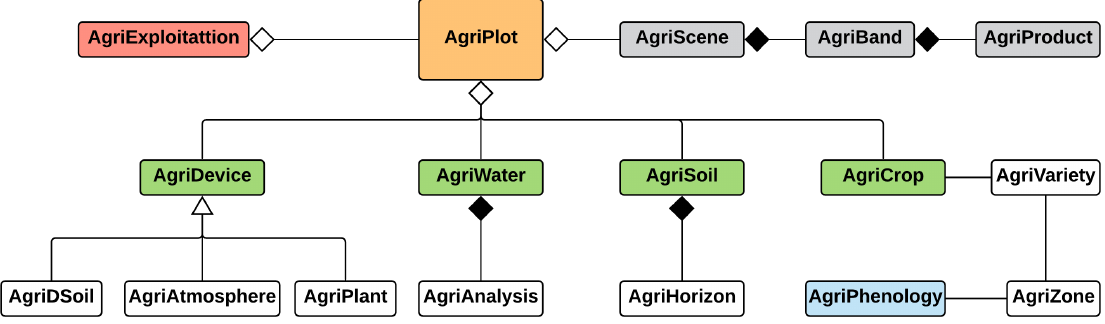
Figure 1. Specific data model for agricultural plot